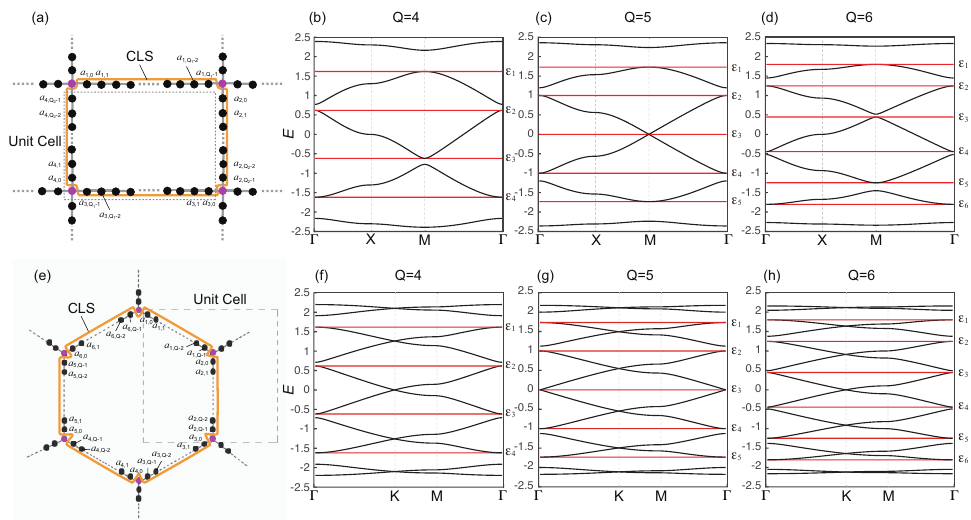
Figure 1. In ( a , e ), we plot the rectangular and honeycomb network superstructures with dot-type links, respectively. CLSs are represented by yellow closed lines. When Q 1 = Q 2 , the rectangular network superstructure becomes the square network superstructure. Dot-type links are represented by the purple color. a m , n reads the amplitude of the CLS. In the network superstructures with dot-type links, the CLS’s amplitude at the dot-type link is always zero. In the unit cell of the rectangular network, we have Q 1 + Q 2 + 1 sites, while we have 3 Q + 2 sites in the honeycomb case. From ( b – d , f – h ), we plot band structures of the square and honeycomb network superstructures with different sizes Q . Here, red lines represent the flat bands, whose energies are denoted by ε n . Here, only the nearest-neighbor hopping processes are